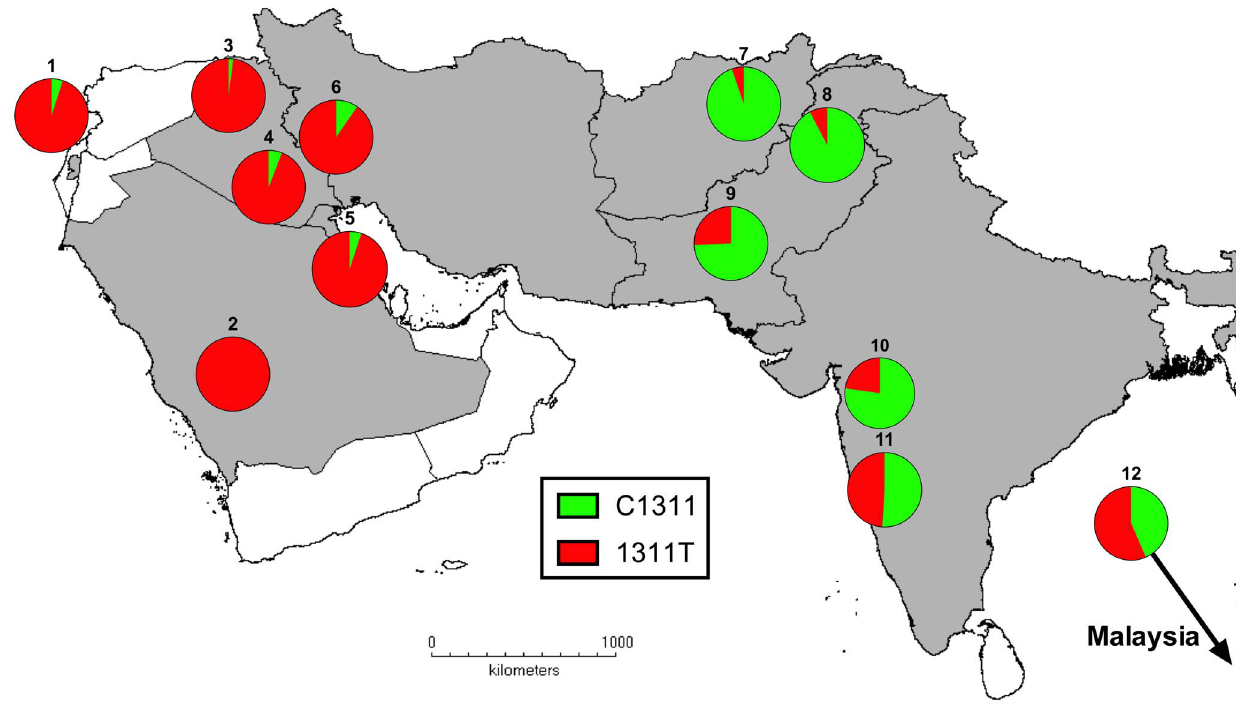
Figure 3. Allele frequencies at 1311C . T marker in individuals carrying 563C . T mutation in southwest Asia. Data are derived from published studies of individuals (expressed as chromosomes) and this study. Countries of study and references are as follows: 1=Palestine [25], 2=Saudi Arabia [18], 3=Iraq (Kurds) [26], 4=Iraq (Baghdad) [27], 5=Kuwait [17], 6=Iran (Kurds) [28], 7=Afghanistan (this study), 8=Pakistan (northwest) [10], 9=Pakistan (Karachi) [30], 10 and 11=India (Bombay) [29,31], 12=Malaysia [6].